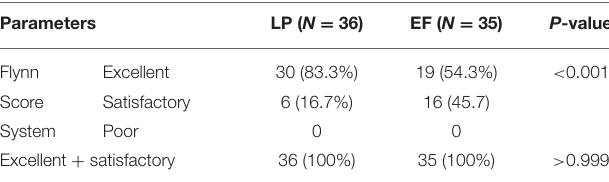
TABLE 5 | Clinical parameters after implant